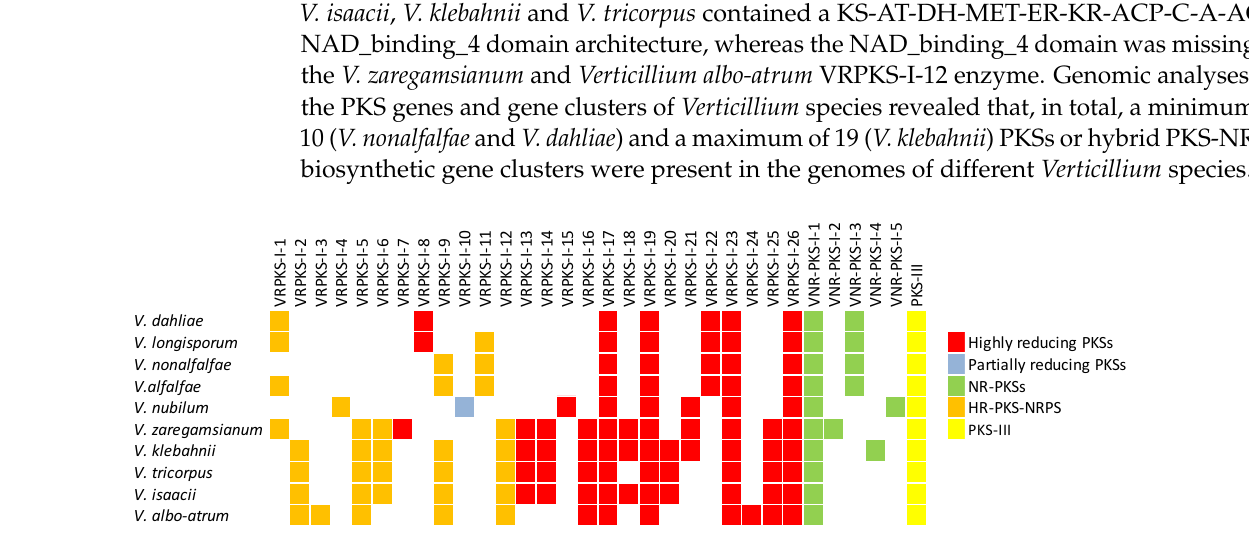
Figure 3. Predicted PKS and PKS-NRPS biosynthetic genes in different Verticillium species. Table 2. Comparison of the size (in amino acid residues) and domain structure of the Verticillium NR-PKS-I proteins with that of the top BLASTp hit in the NCBI database.